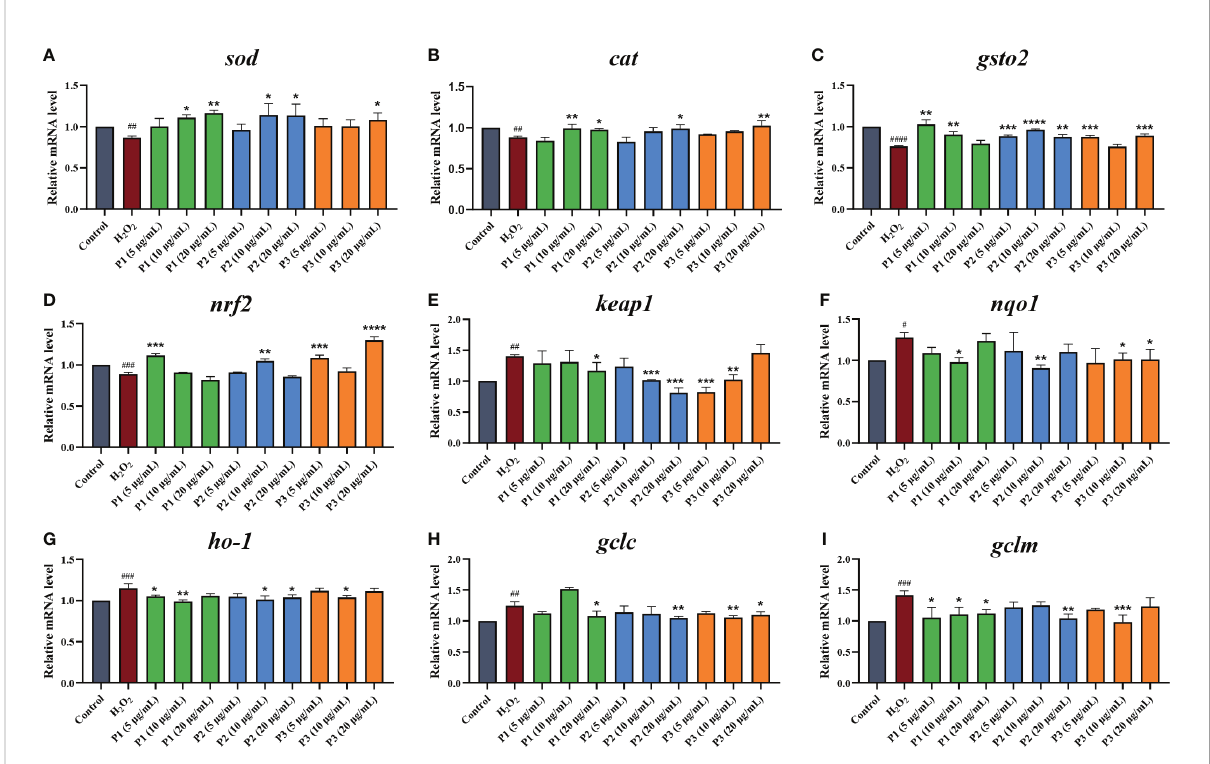
FIGURE 6 Effect of antioxidant peptides on the relative mRNA expression levels of (A) SOD. (B) CAT. (C) GSH-Px. (D) NRF2. (E) KEAP1. (F) NQO1. (G) HO-1. (H) GCLC. (I) GCLM. * p < 0.05, **p < 0.01, *** p < 0.001, **** p < 0.0001 vs. the H 2 O 2 group. # p < 0.05, ## p < 0.01, ### p < 0.001, #### p < 0.0001 vs. the blank control